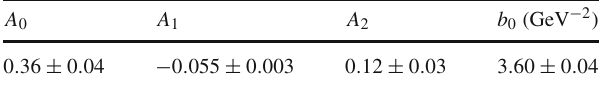
Fig. 1 The Feynman diagrams of the two gluon exchange model for vector mesons